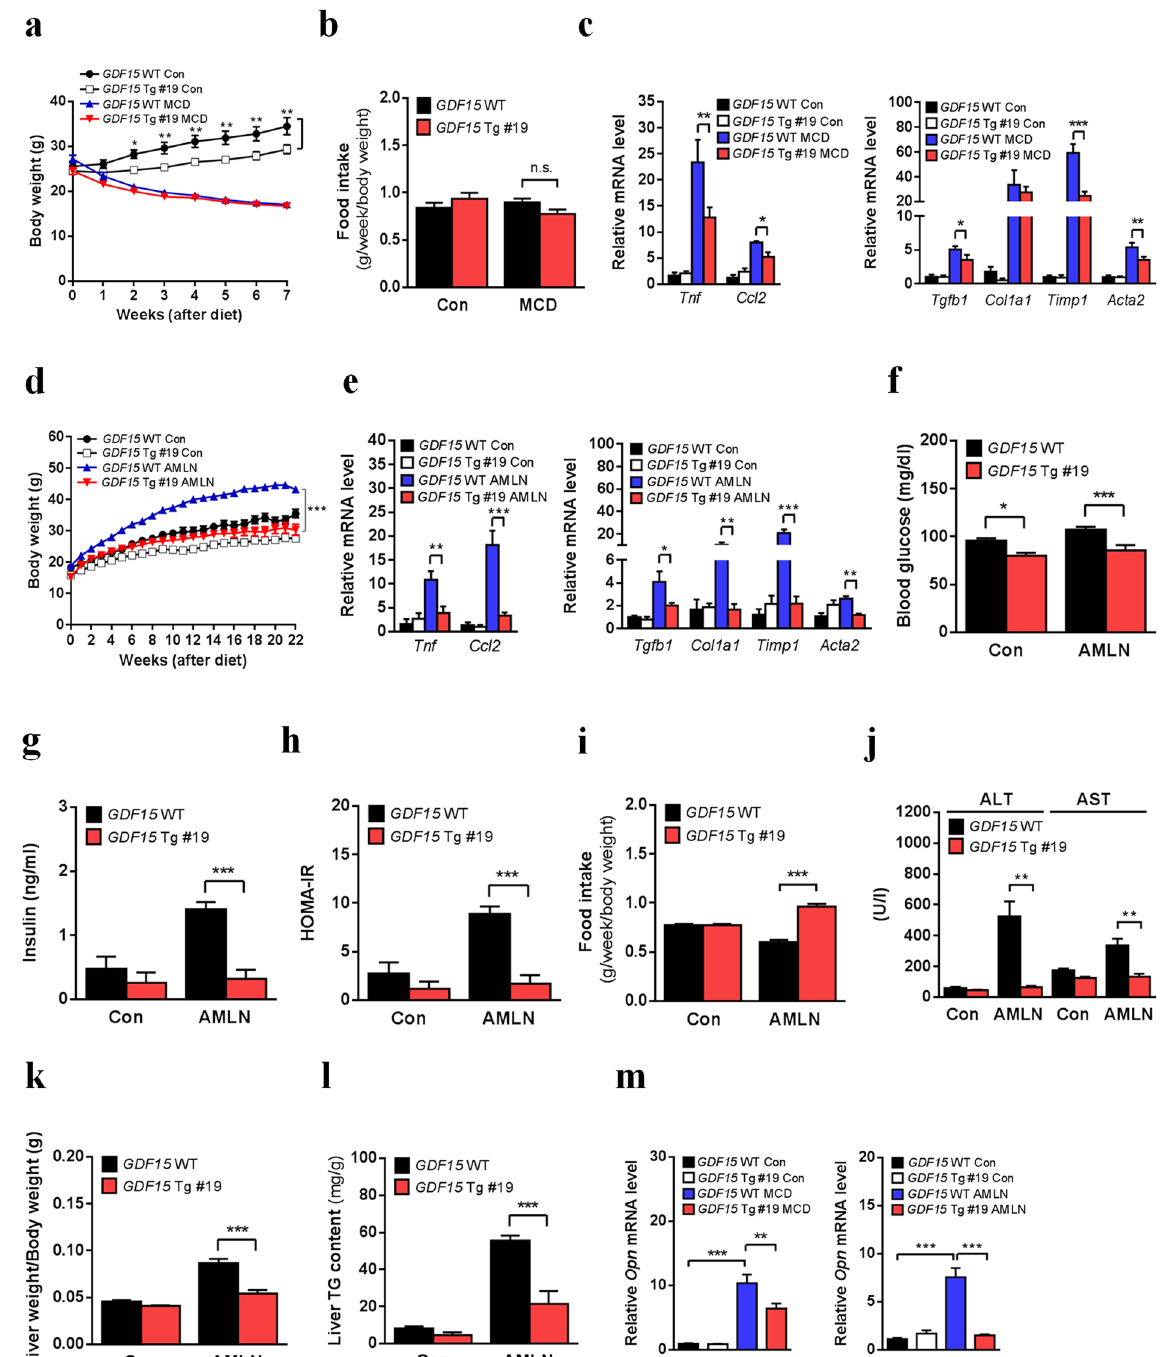
Figure 6. GDF15 overexpression ameliorates NASH phenotypes and related metabolic deterioration in mice. ( a – c ) Body weight ( a , n = 3–10), food intake adjusted for body weight ( b , n = 3–6), relative inflammatory gene expression (left panel of c , n = 3–5) and relative fibrosis-related gene expression (right panel of c , n = 3–5) in GDF15 -Tg line 19 and control mice fed MCD diet for 7 weeks. ( d – l ) Body weight ( d , n = 4–11), relative inflammatory gene expression (left panel of e , n = 4–6), relative fibrosis-related gene expression (right panel of e , n = 4–6), fasting glucose level ( f , n = 4–11), fasting insulin level ( g , n = 4–11), HOMA-IR index ( h , n = 4–11), food intake adjusted for body weight ( i , n = 4–11), serum ALT/AST levels ( j , n = 4–11), liver weight adjusted for body weight ( k , n = 4–11) and liver TG content ( l , n = 4–11) in GDF15 -Tg line 19 and control mice fed AMLN diet for 22 weeks. ( m ) Relative hepatic Opn mRNA levels in GDF15 -Tg line 19 and control mice fed MCD for 7 weeks (left, n = 3–5) or AMLN diet for 22 weeks (right, n = 4–6). Data are means ± SEM. * p < 0.05, ** p < 0.01, *** p <